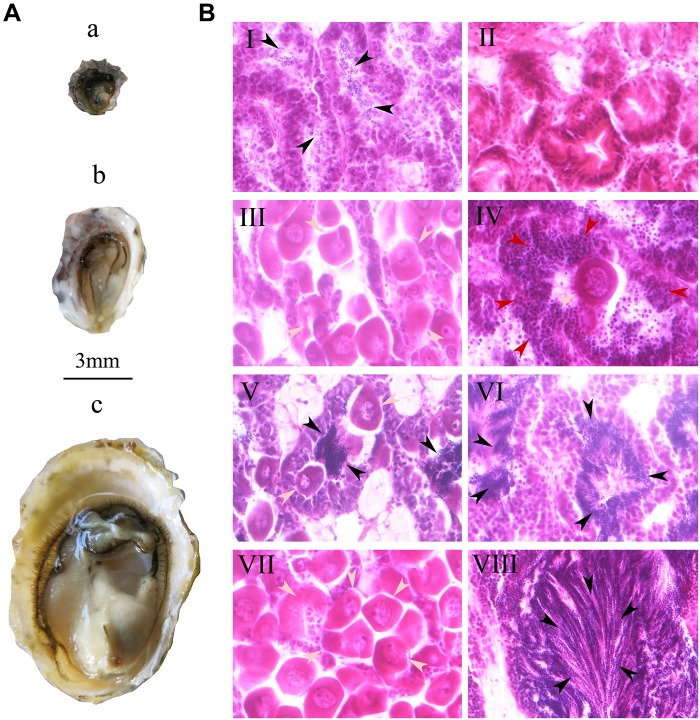
Gonad of oyster Crassostrea sikamea
(A) and gametogenesis (B) during the early life history at the first three months stage. In plane A: a, One month old oyster; b, Two month old oyster; c: Three month old oyster. In plane B: I, Male at one month; II, Asexuality at one month; III, Female at two month; IV, Hermaphrodite (spermatocyte and oocyte) at two month; V Hermaphrodite (Sperm and oocyte) at two month; VI, Male at two month; VII, Female at three month; VIII, Male at three month. In panels B, the gray, black, and red arrows indicate oocytes, sperms and spermatocytes, respectively. All histological section pictures were taken under multiple of ×40.